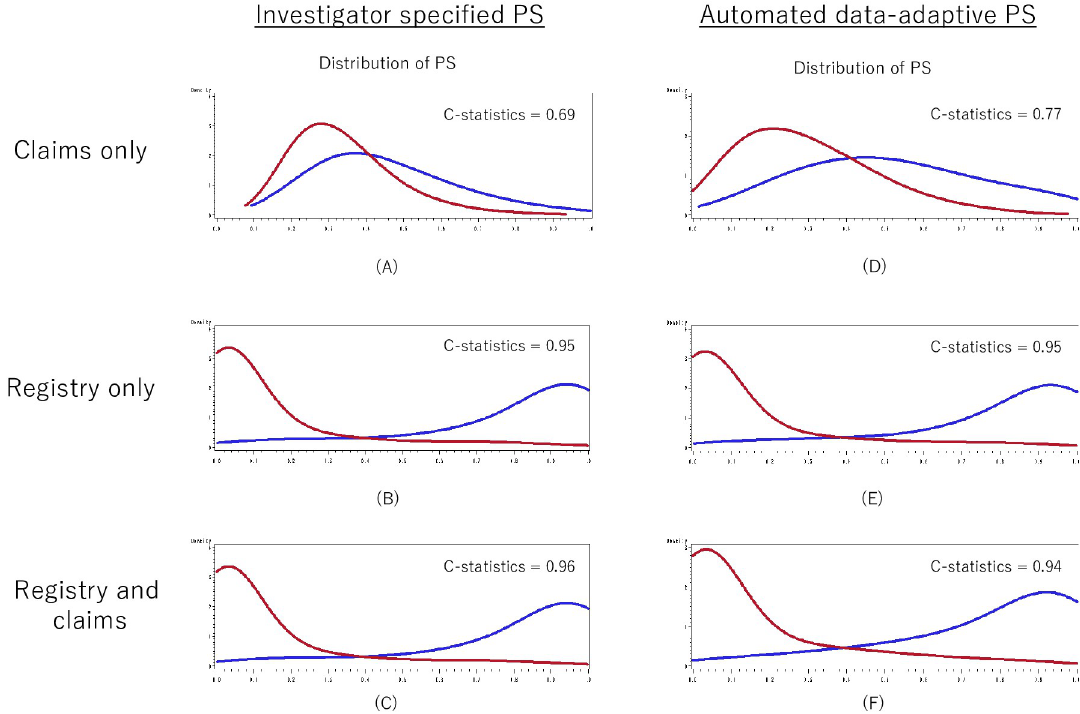
Fig 3. Distribution of the propensity scores estimated from the models with different combinations of data source and variable selection approach. Abbreviations: PS = propensity score.